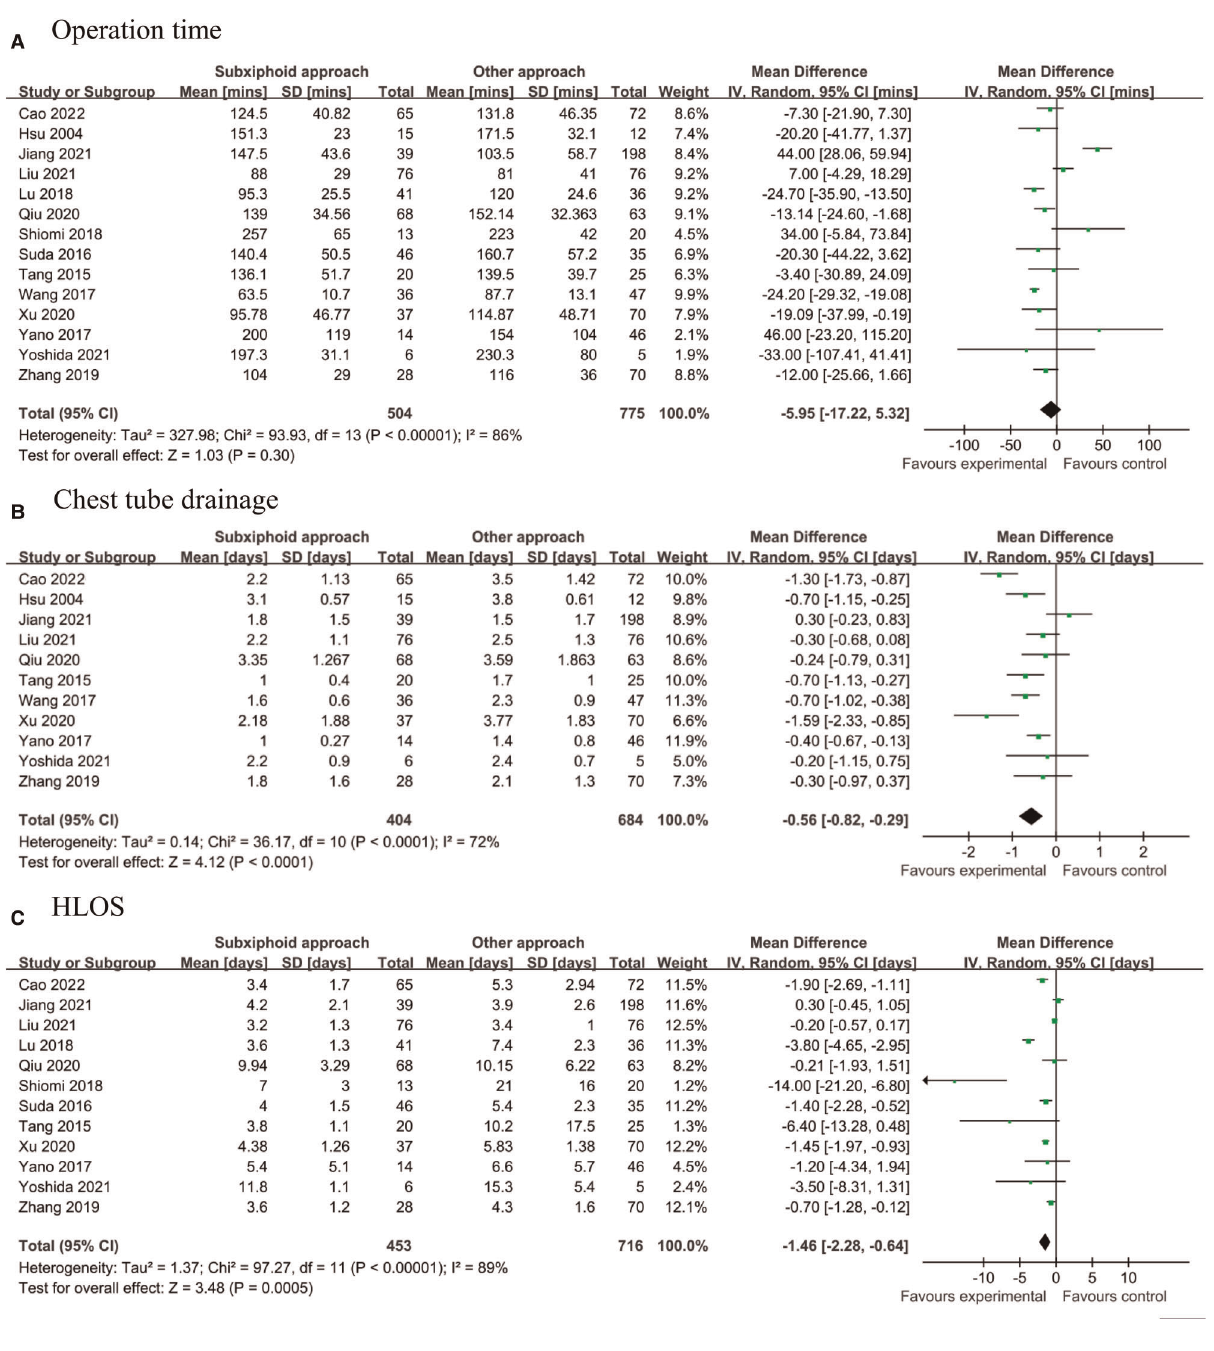
FIGURE 3 | Pooled estimates of included studies evaluating the effect of subxiphoid approach on ( A ) operation time, ( B ) duration of chest tube drainage, and ( C ) HLOS. HLOS, hospital length of